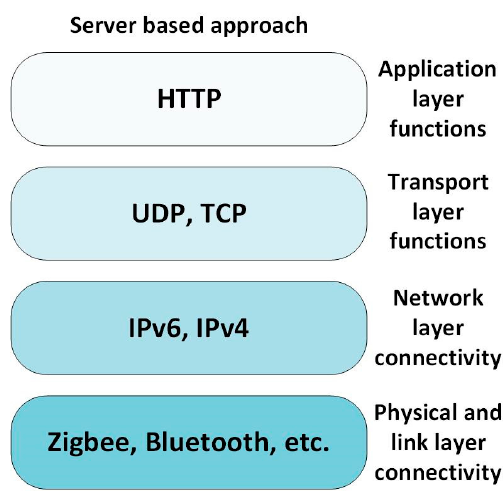
Figure 3. Server-based architecture.